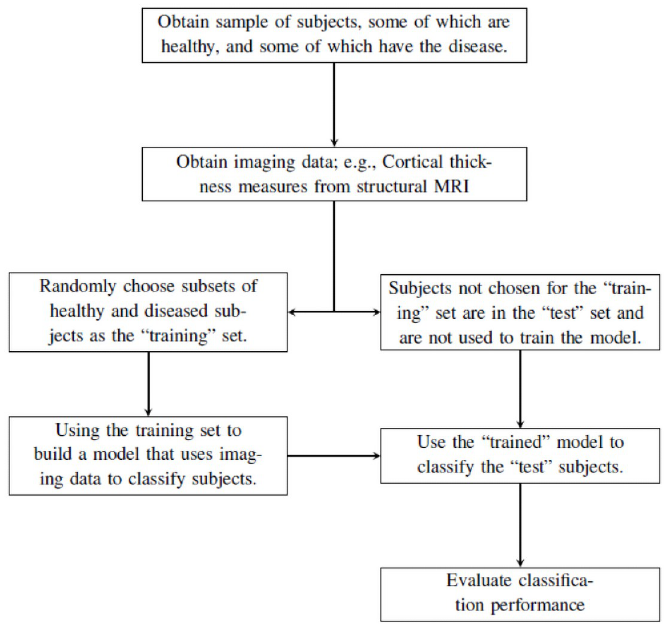
Fig 1. This flow chart describes the basic process of building and evaluating a